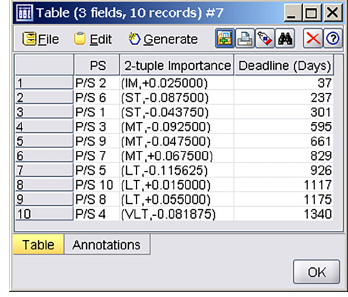
Figure 5. Final results sorted and expressed using the final set of labels